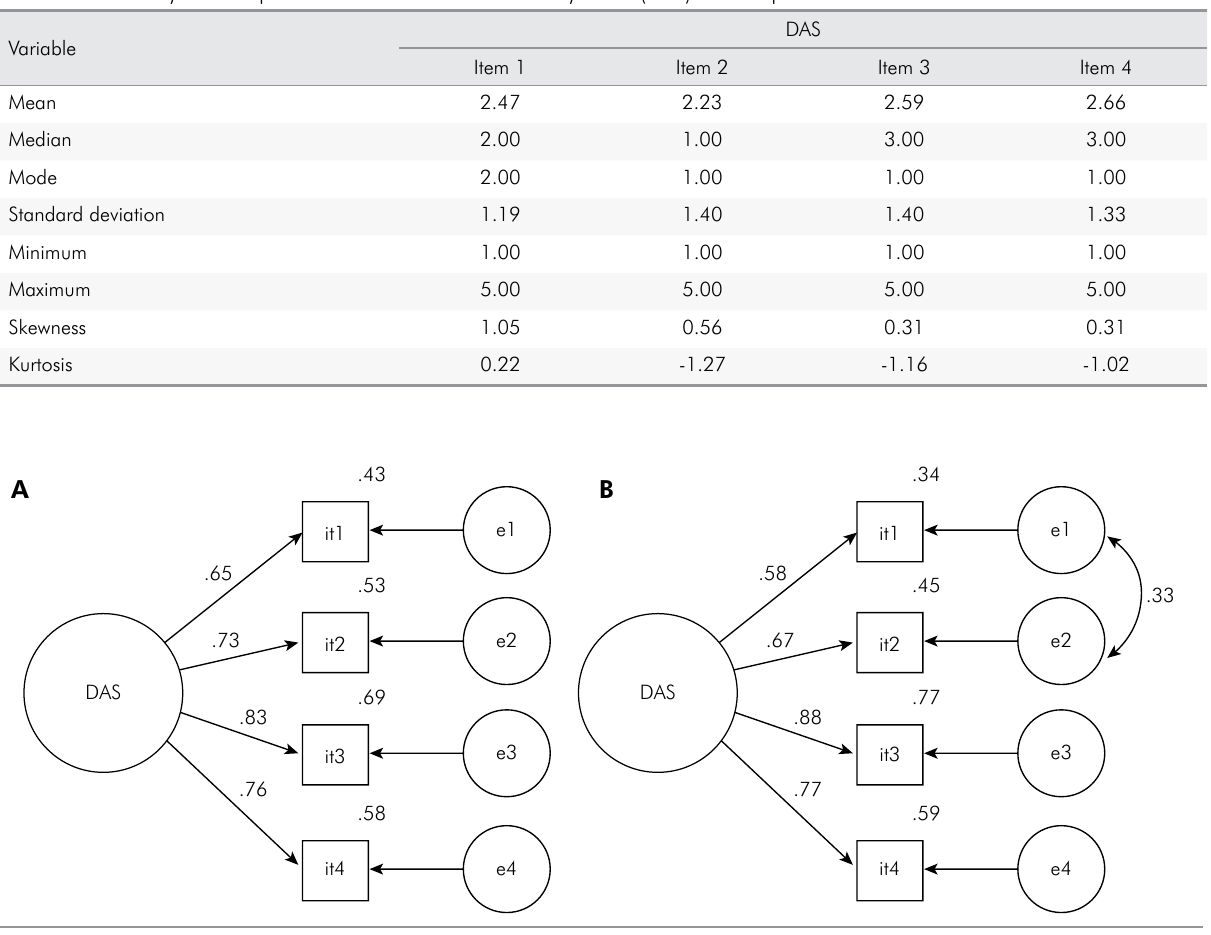
Figure 1. One-factor model (A = original; B = adjusted) of the Dental Anxiety Scale (DAS).